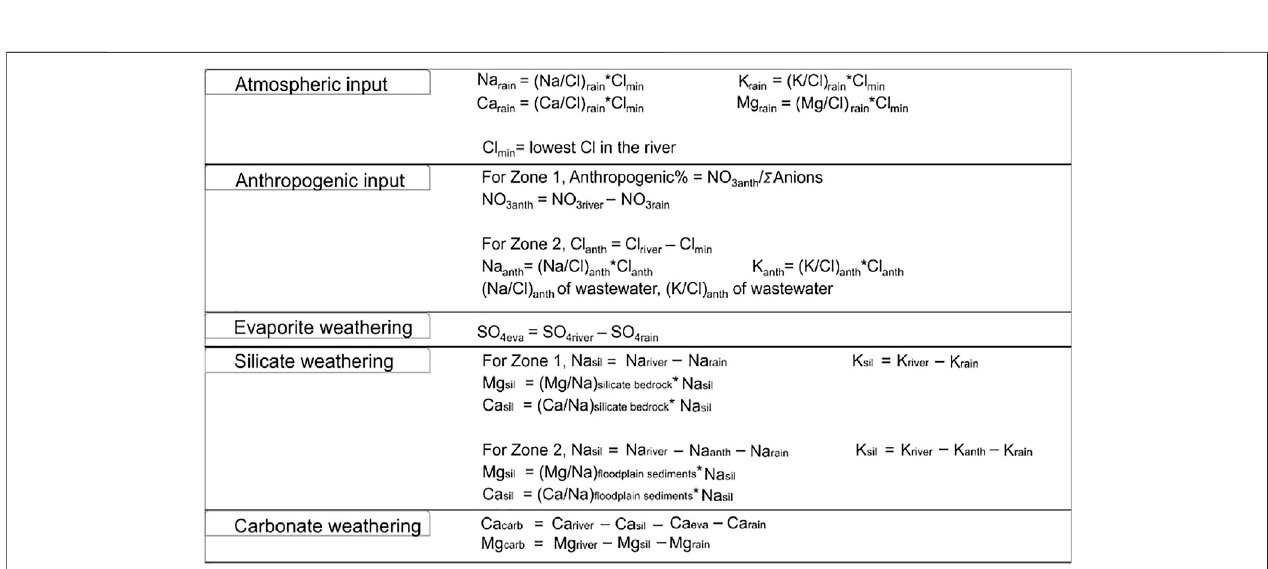
FIGURE 2 | Geological and land use land cover (LULC) map of the year 2014 – 2015 (Modi fi ed after Panwar et al. (2020)).